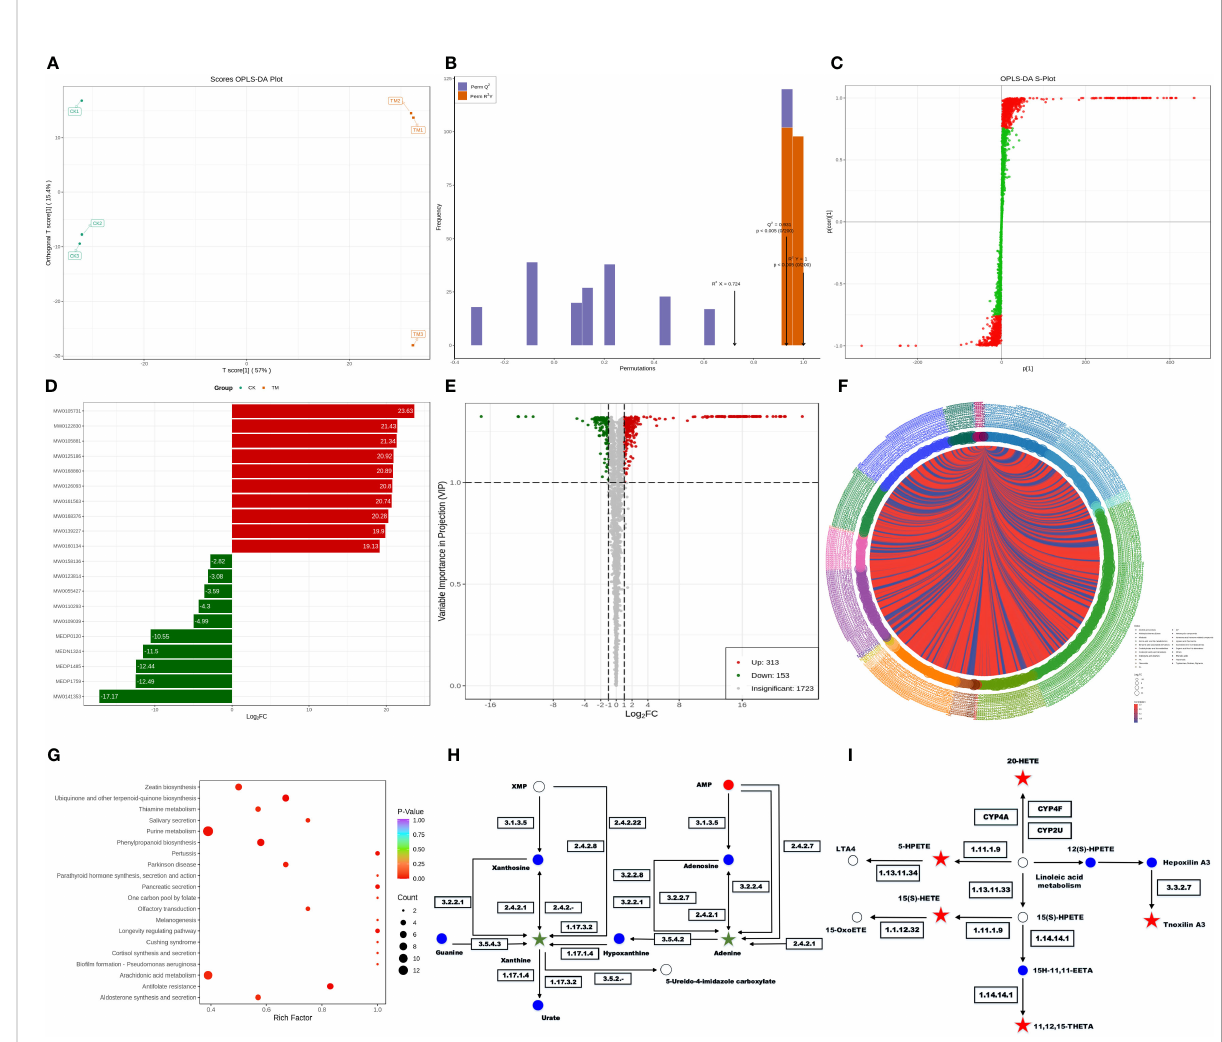
FIGURE 5 Effect of the antifungal compound PCN on the R. solani AG1IA metabolome. (A) OPLS-DA scoring result; (B) OPLS-DA model validation outcome; (C) S-plot of OPLS-DA; (D) bar graph of differential metabolites; (E) volcano plot of differential metabolites; (F) chord diagram of differential metabolites; (G) KEGG enrichment plot of differential metabolites; (H) KEGG pathway diagram of purine differential metabolites; (I) KEGG pathway diagram of arachidonic acid key differential